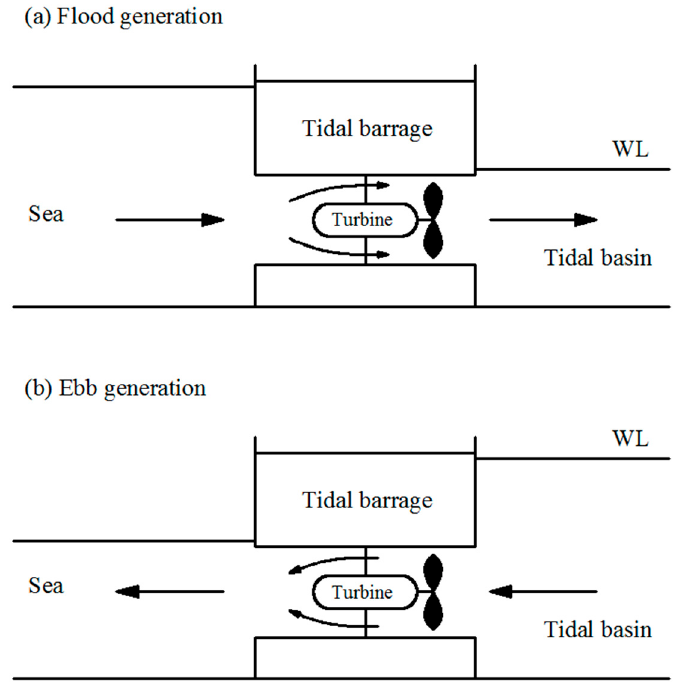
Figure 7. Tidal barrage principles.